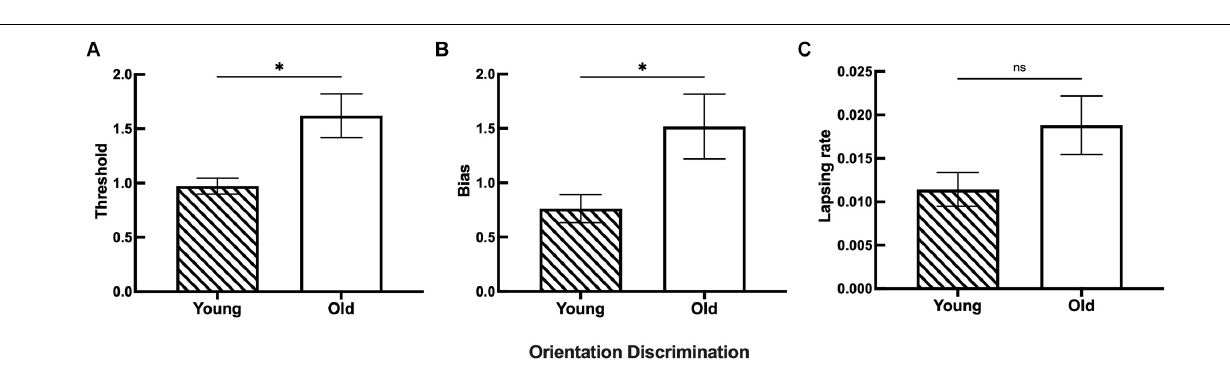
FIGURE 5 | A diagram of psychometric curve and meaning of threshold, bias, and lapsing rate. The threshold represents the horizontal distance between the threshold point and midpoint of the curve. The bias represents the horizontal distance between the midpoint and x = 0. The lapsing rate represents the vertical distance between the maximum of the curve and y =